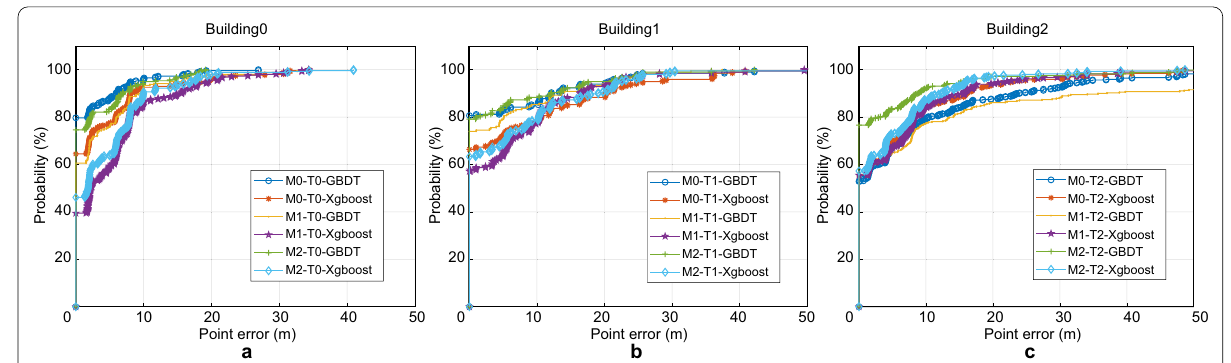
Fig. 14 The CDFs of the proposed method after deleting some